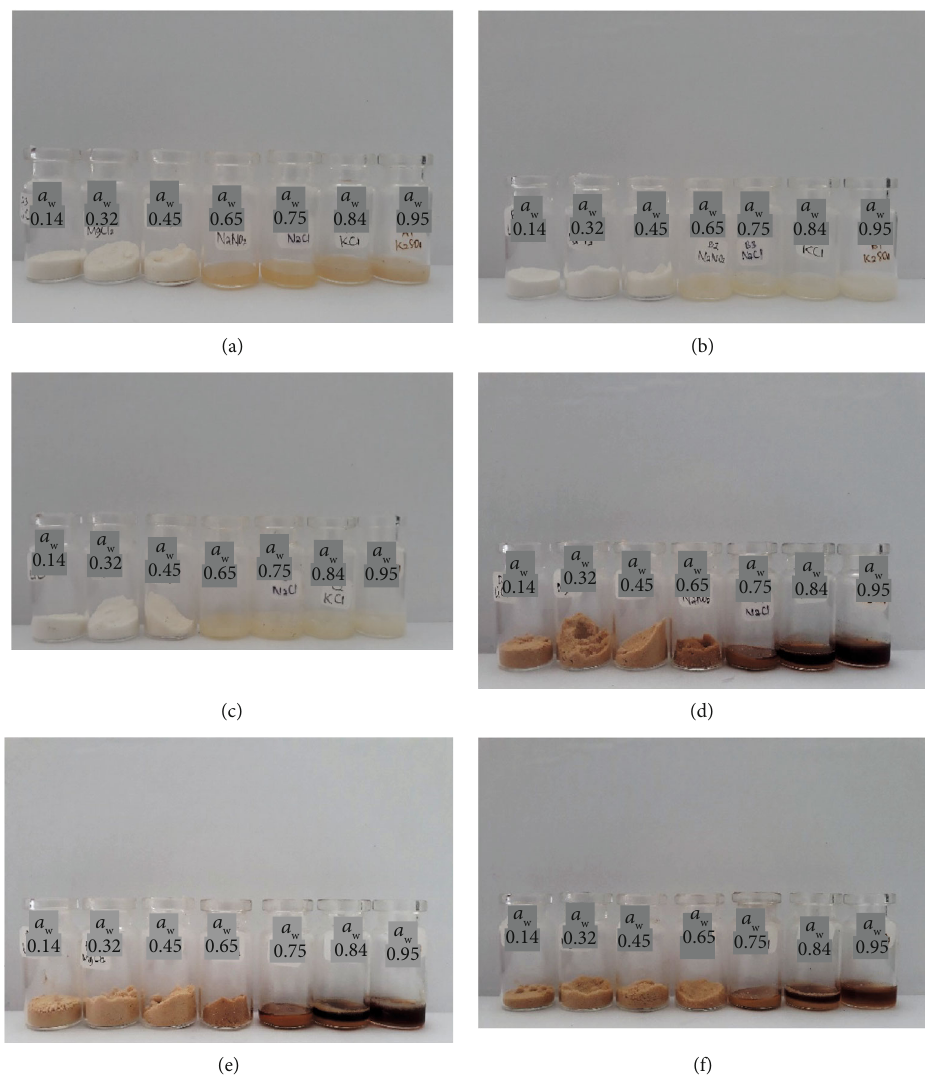
Figure 4: The coconut sugar stored at various water activities. (a – c) Vacuum-dried sugar without the addition of TCP, with TCP 0.5%, and with TCP 1%, respectively. (d – f) Conventional sugar without the addition of TCP and with the addition of TCP 0.5% and TCP 1%,